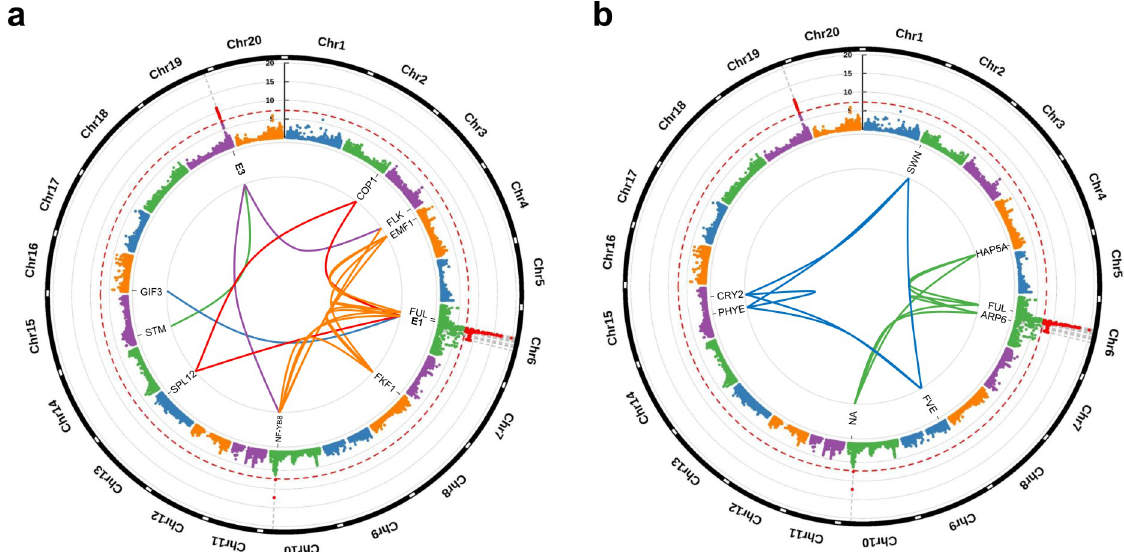
Fig 3. Epistatic interactions among DTF-related genes. a. Epistatic interactions between non-significant genes and significant genes ( E1 and E3 ). Inner curved lines indicate interaction groups, G1 (navy), G2 (red), G3 (orange), G4 (green), and G5 (purple) (Table 2). b. Epistatic interaction between non-significant genes. Inner curved lines indicate interaction groups, G6 (green) and G7 (navy) (Table 2). Red dotted lines in the two plots indicate statistically significant cut-off thresholds of − log( p -value) = 7.